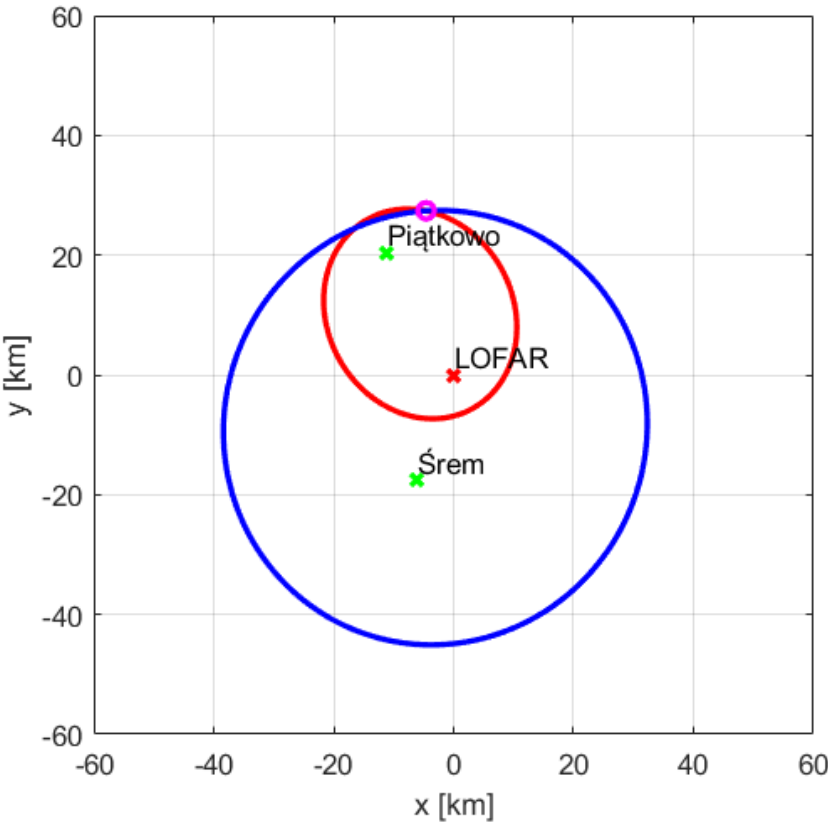
Figure 18. Intersection of ellipses for